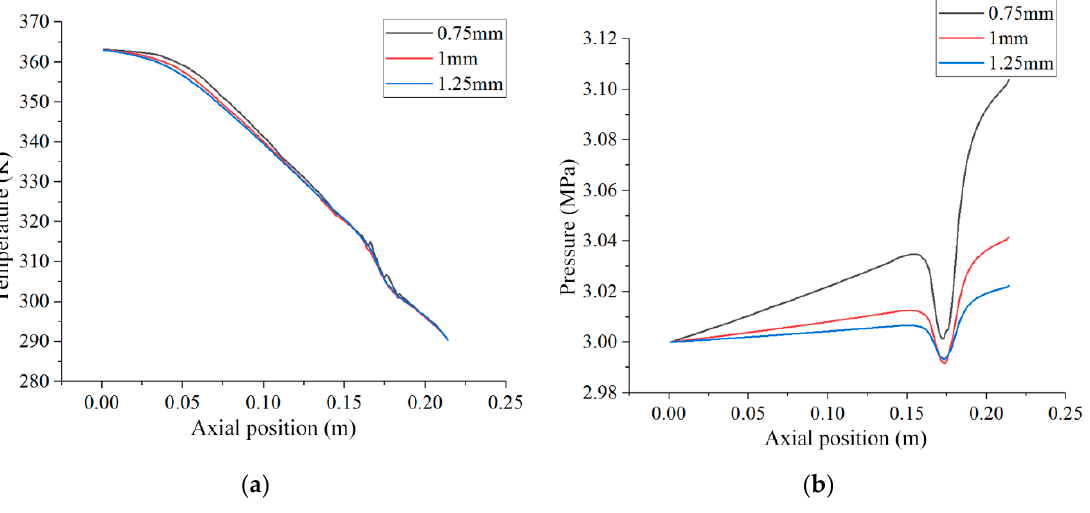
Figure 16. Temperature and pressure along the course of coolant with different rib heights. ( a ) Tem- perature along the course of coolant; ( b ) pressure along the course of coolant. ( a ) Temperature along the course of coolant; ( b ) pressure along the course of